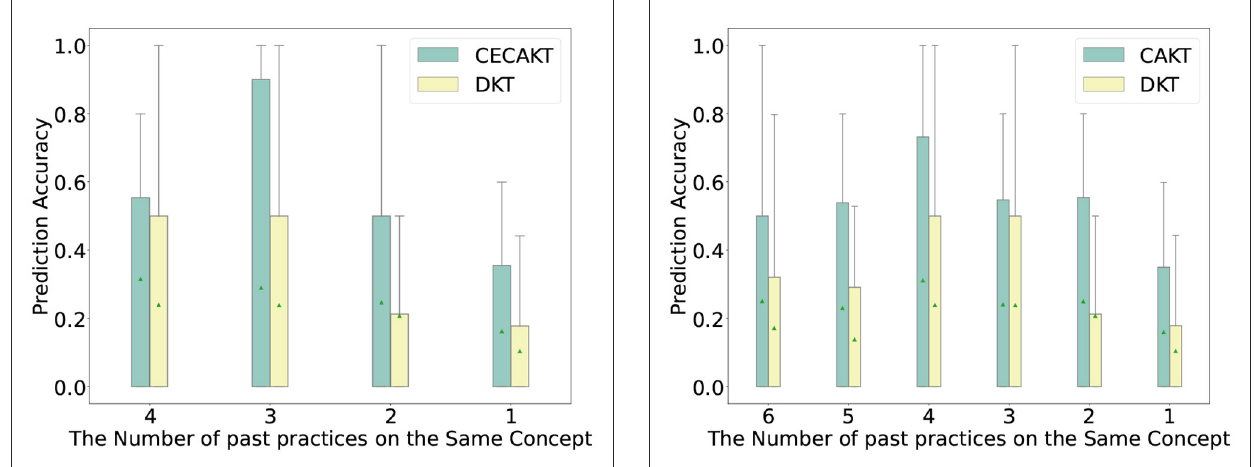
FIGURE7 Prediction accuracy for interactions with different number of past practices on the same knowledge concept, CAKT Vs.